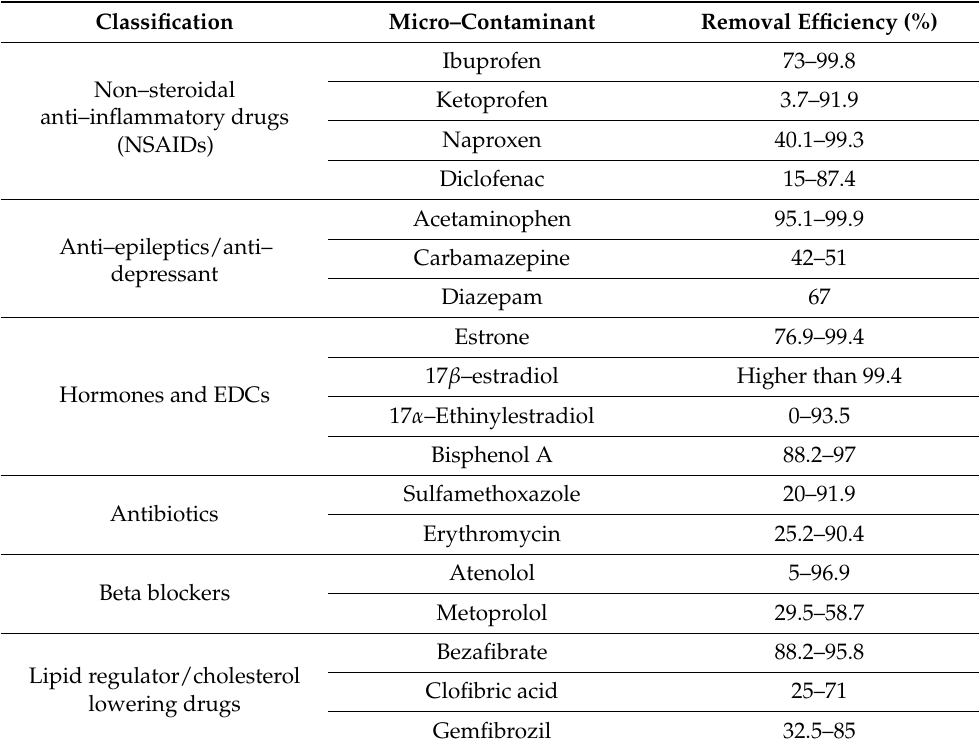
Table 4. The removal performance of various pharmaceutical micro-contaminants from aquatic environments using the MBR system [123–130].